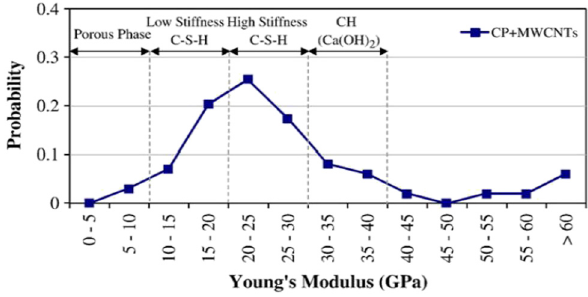
Figure 17: Probability plot of Young ’ s modulus of 28 - day cement paste and cement paste reinforced with 0.08 wt% short MWCNTs ( w/c = 0.5 ) [ 49 ]